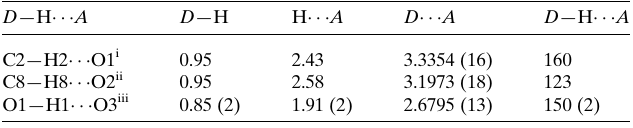
Table 3 Hydrogen-bond geometry (A˚ , (cid:3) ) for 3